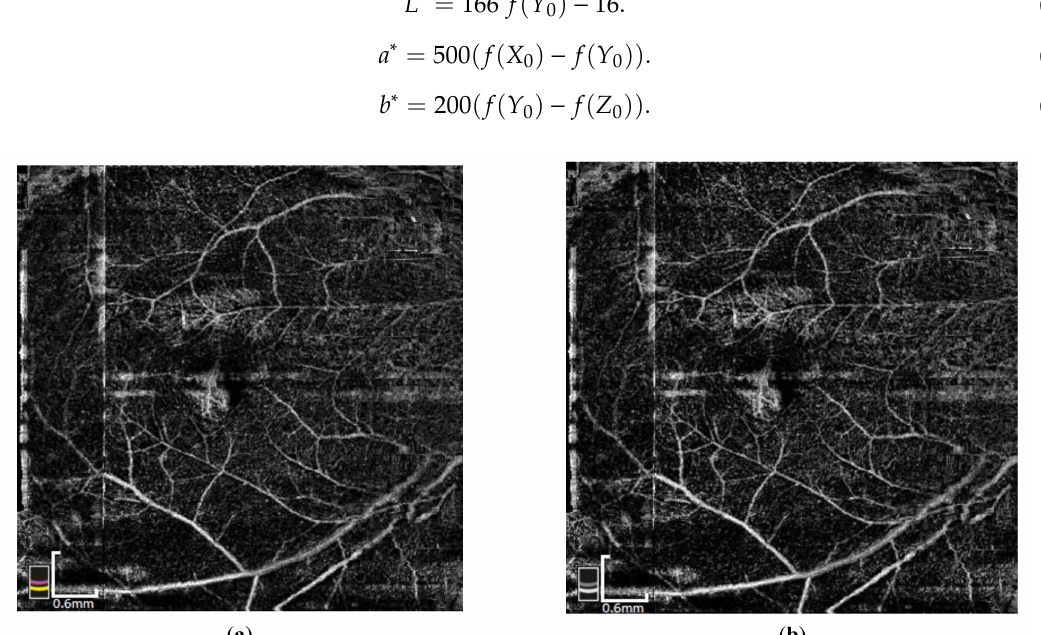
Figure 2. An example of CIELAB color transform: ( a ) Input optical coherence tomography angiography (OCTA) image; ( b ) L-channel of image in CIELAB color